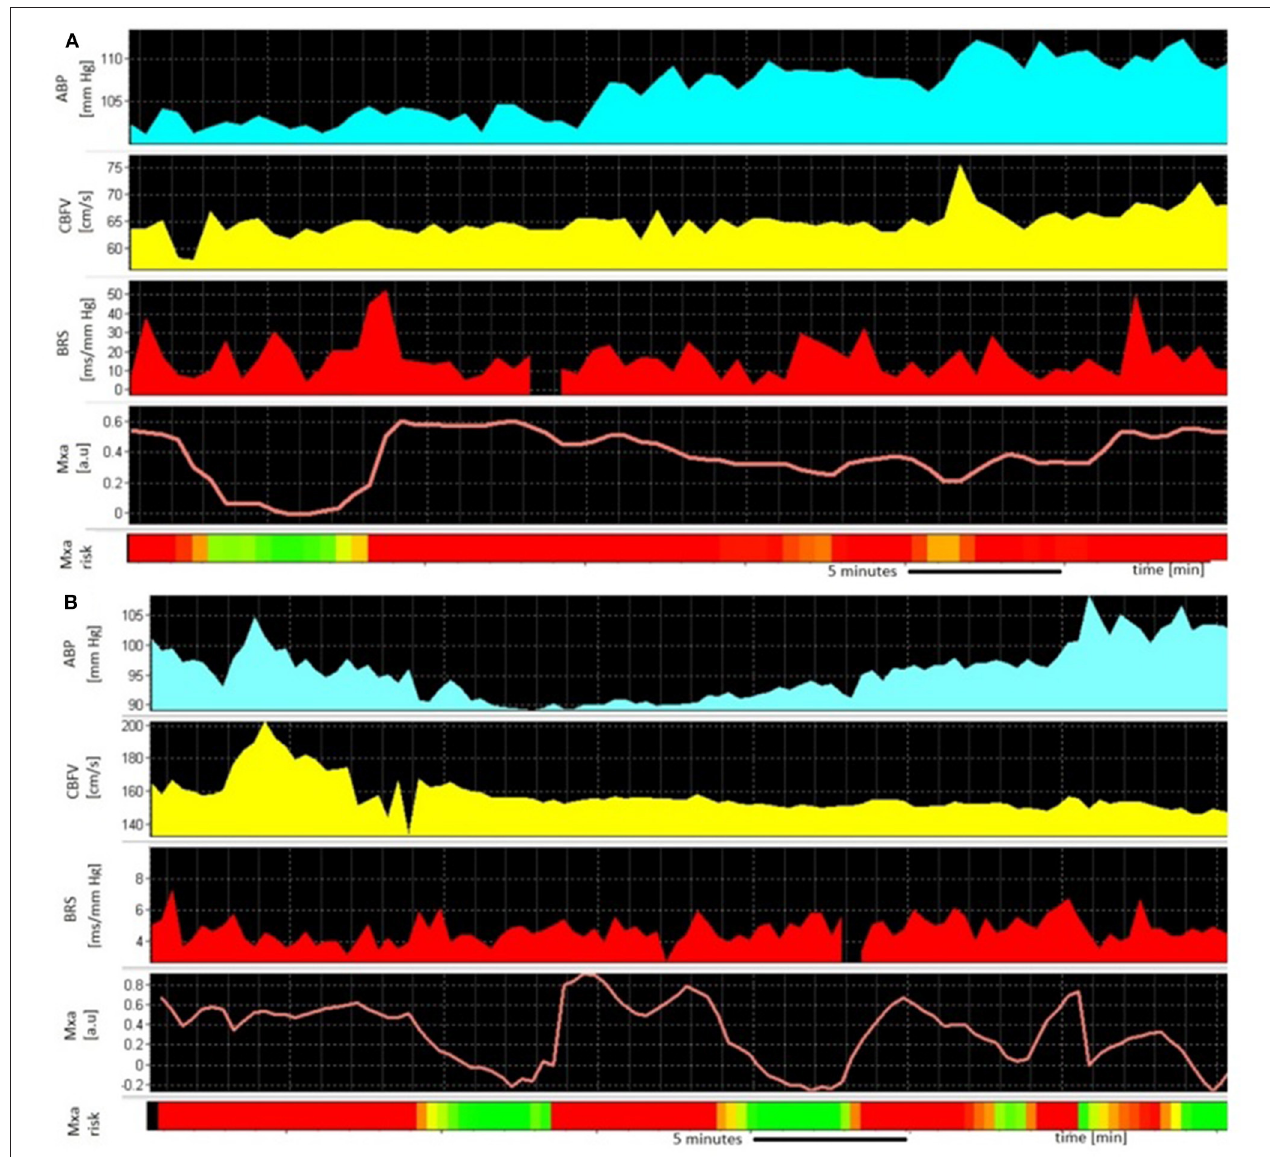
FIGURE 2 | An example of the monitoring of (A) 45-year old man without cerebral vasospasm (CV) 12 days after aneurysmal subarachnoid hemorrhage (aSAH) from a ruptured aneurysm in the posterior cerebral artery (PCA). The high values of Mxa [worse cerebral autoregulation (CA), red panel] are counterbalanced with efficient, high-cardiac baroreflex sensitivity (BRS); (B) 67-year old woman during CV 8 days after aSAH from a ruptured aneurysm in the anterior communicating artery (ACom). The high values of Mxa (worse CA, red panel) occur in parallel with disrupted, low BRS; ABP, arterial blood pressure; CBFV, cerebral blood flow velocity; BRS, baroreflex sensitivity; Mxa, mean velocity index; the Mxa above 0.3 is interpreted as